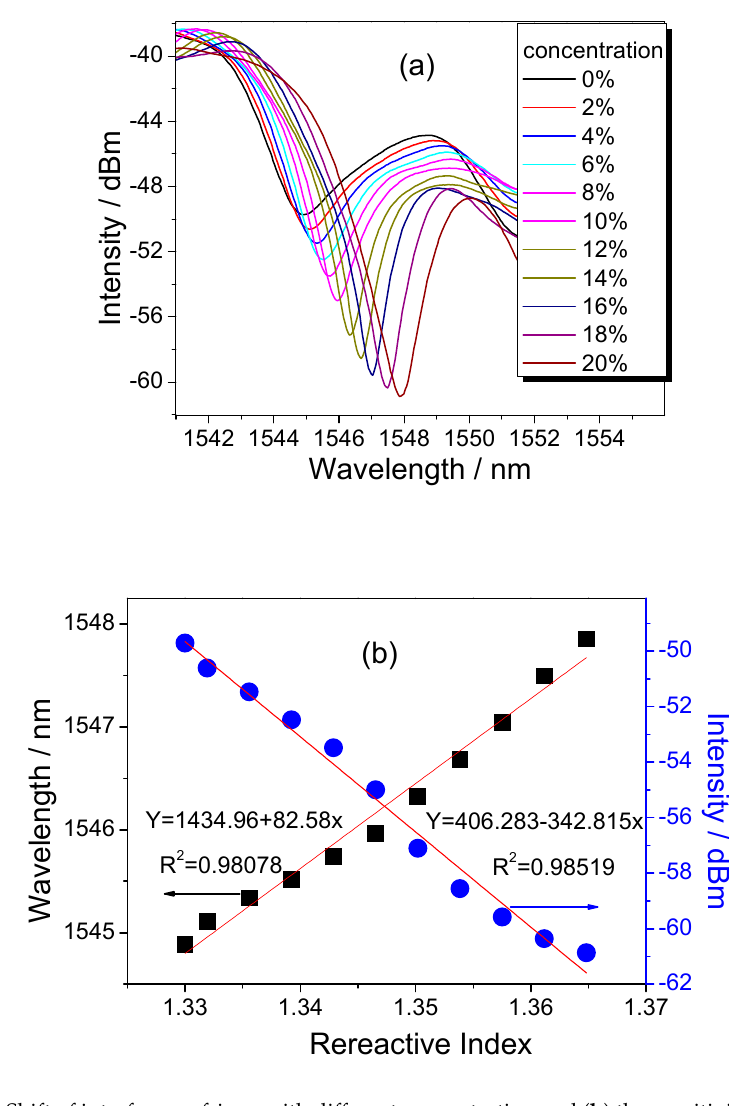
Figure 5. ( a ) Shift of interference fringe with different concentration and ( b ) the sensitivity and linearity of wavelength and intensity with varied RI.